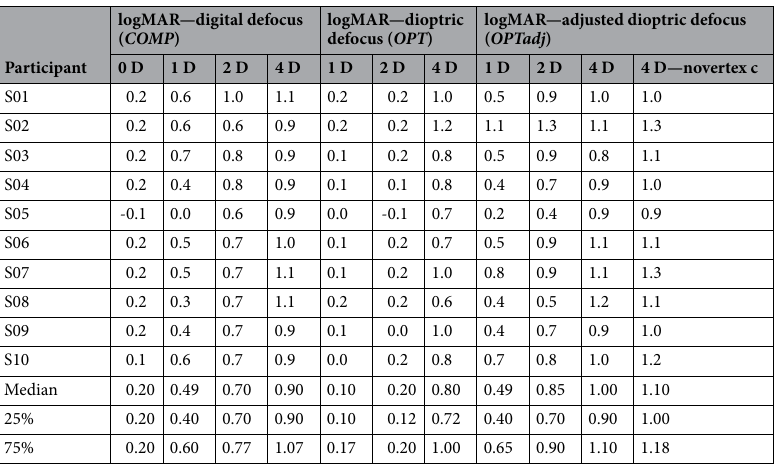
Table 1. VA (logMAR) and descriptive statistics for all three methods and levels of the blur; 25% (75%)— lower (upper) quartile; S01-S10—participant’s code. The last column represents VA measured for OPTadj condition without the vertex